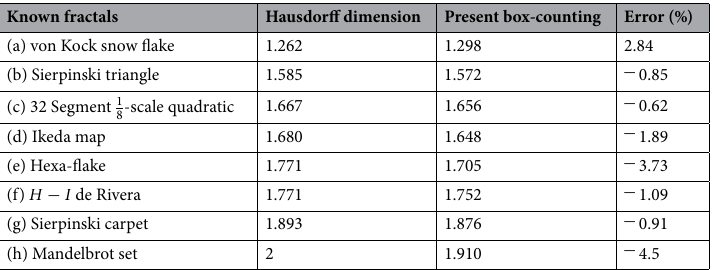
Table 3. Fractal dimensions from the present box-counting 72,73 compared to the corresponding Hausdorff dimensions of known geometrical patterns 73 shown in Fig.